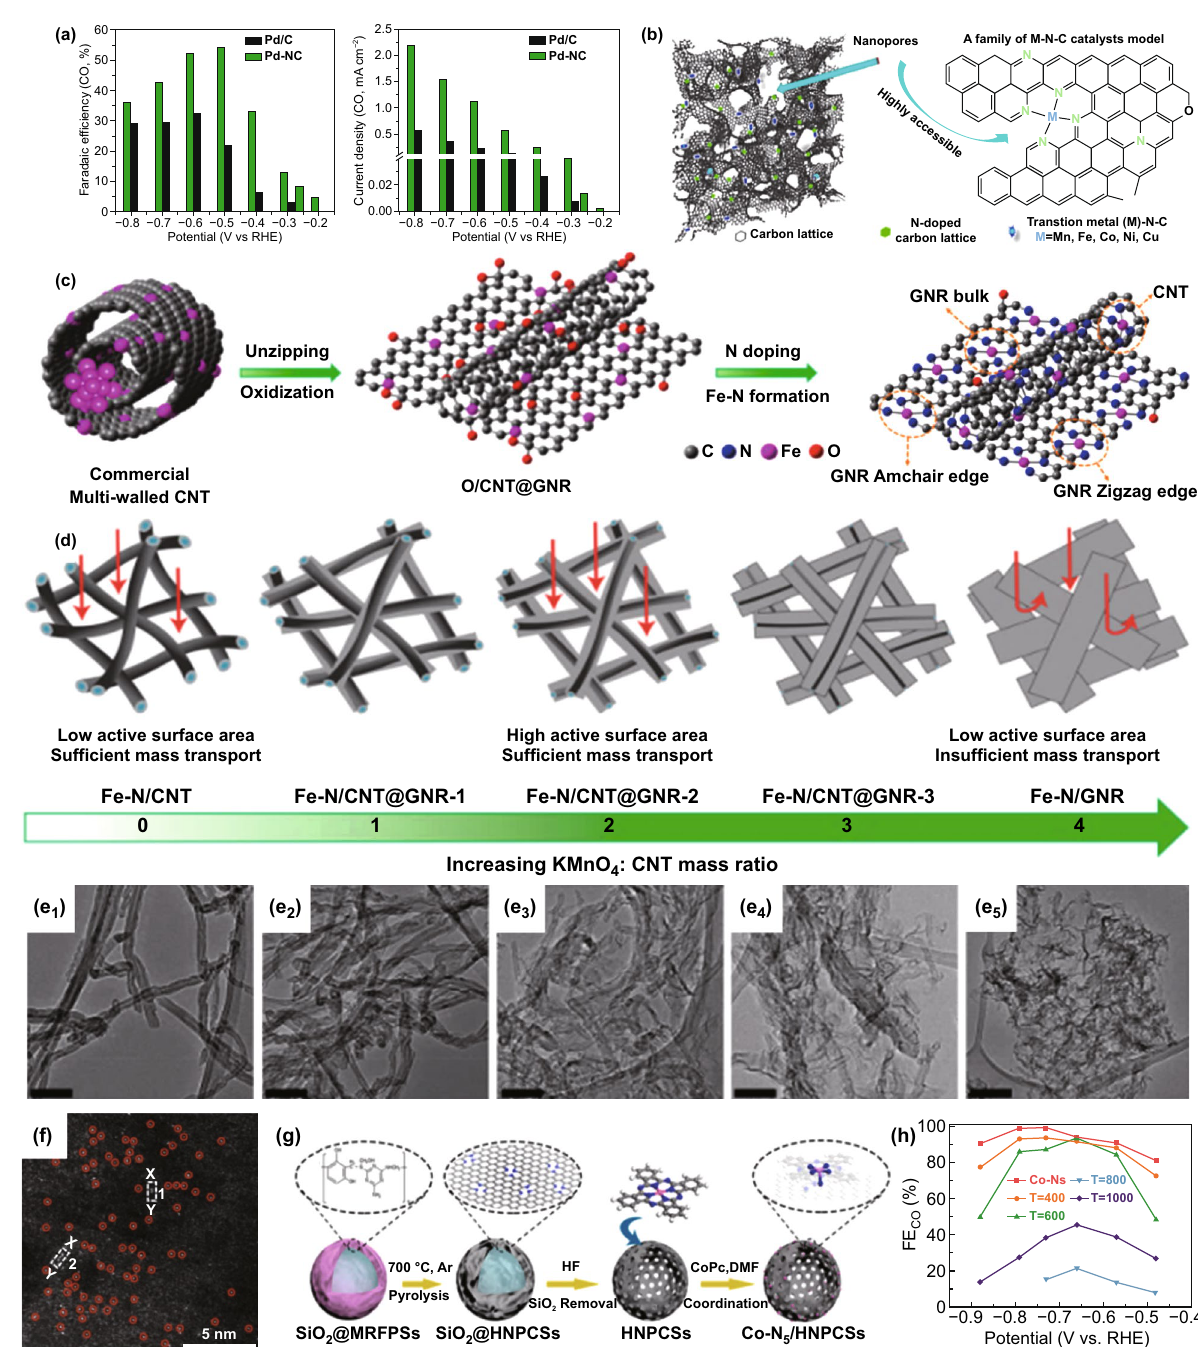
Fig. 6 Metallic atomically dispersed active sites. a ECR performance of two catalysts [50]. Copyright © 2020, John Wiley & Sons, Inc. b Mate- rials model and a schematic local structure [120]. Copyright © 2017, Springer Nature. c Schematic illustration of the formation of Fe–N/CNT@ GNR. d Structural evolution GNR. e TEM images of samples obtained with different KMnO4: CNT mass ratios. Scale bar in e1–e5 is 100 nm [121]. Copyright © 2020, American Chemical Society. f HAADF–STEM image of Co1/PCN. g , h Schematic illustration and FECO of Co-N5/ HNPCSs-T [115]. Copyright © 2018, American Chemical